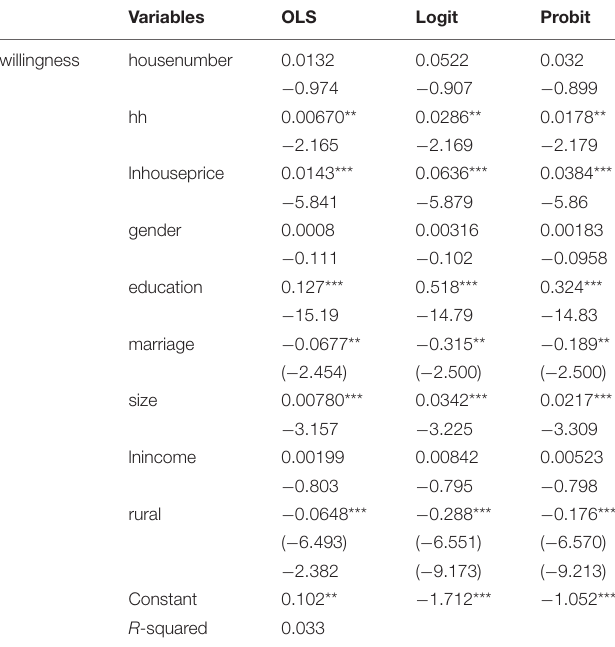
TABLE 7 | Mechanism analyzing results. TABLE 8 | Robustness